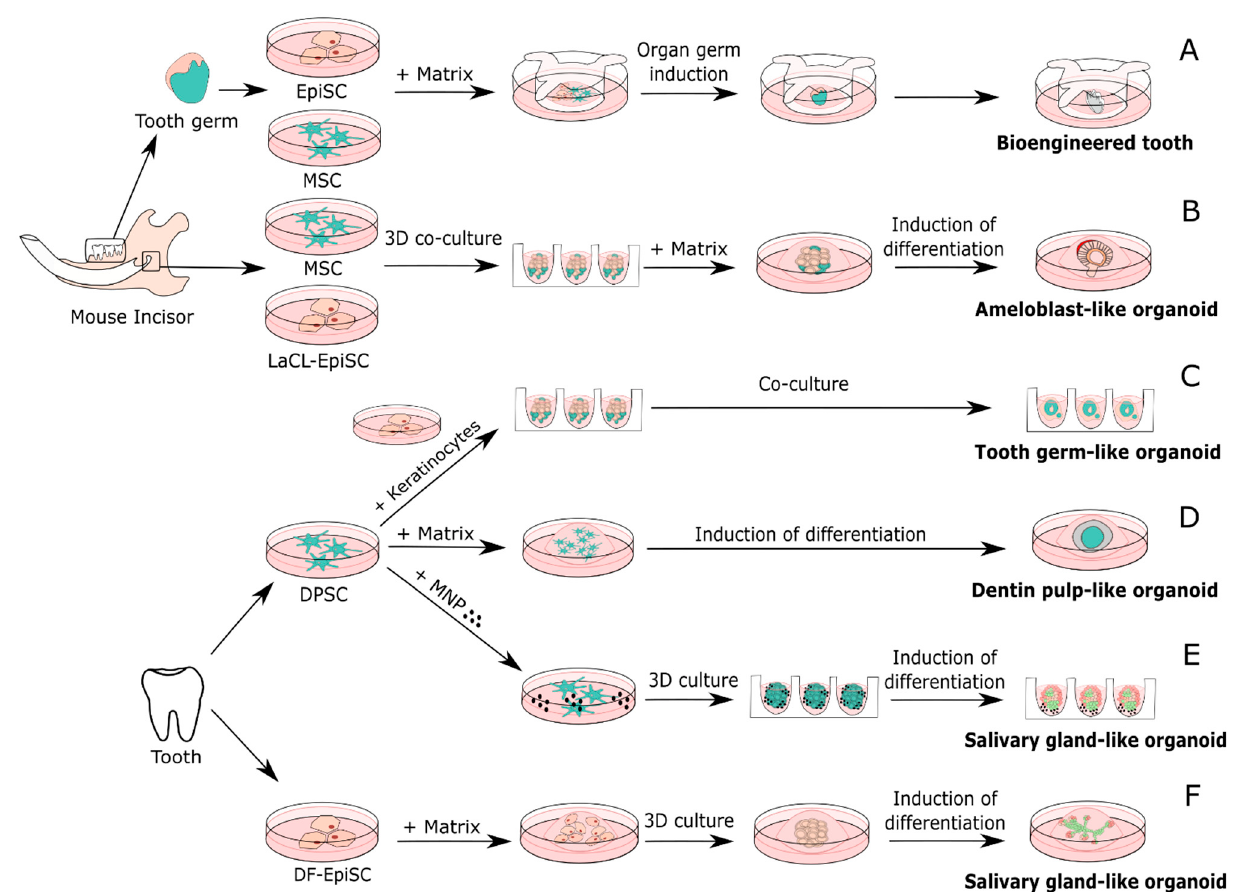
Figure 3. Organoids and organ germs from dental tissues. ( A ) Scheme of the “organ germ method” for the generation of a bioengineered tooth, with cells derived from a tooth germ, cultured in compartments in collagen, inducing the formation a tooth germ in vitro and finally give rise to a bioengineered tooth [193]. ( B ) Scheme of the generation of an ameloblast-like organoid from EpiSCs in the presence of dental mesenchyme, cultured in non-adherent plates, and further propagated in Matrigel with inducing factors [206]. ( C ) Scheme of the generation of tooth germ-like organoids from DPSCs in the presence of keratinocytes in a low-adherent culture [207]. ( D ) Scheme of the formation of dentin pulp-like organoid from DPSCs [208]. ( E ) and ( F ): Scheme of the formation of salivary gland-like organoids by different methods and cells: ( E ) Organoid formation from DPSCs using magnetic nanoparticles and low attachment conditions [209], ( F ) Organoid formation from DF-EpiSCs in a Matrigel matrix [210].